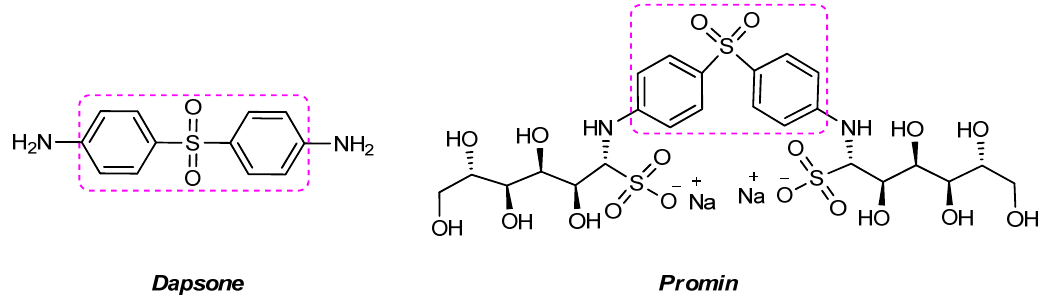
Figure 2. Selected drug molecules that contain diaryl sulfone moieties.